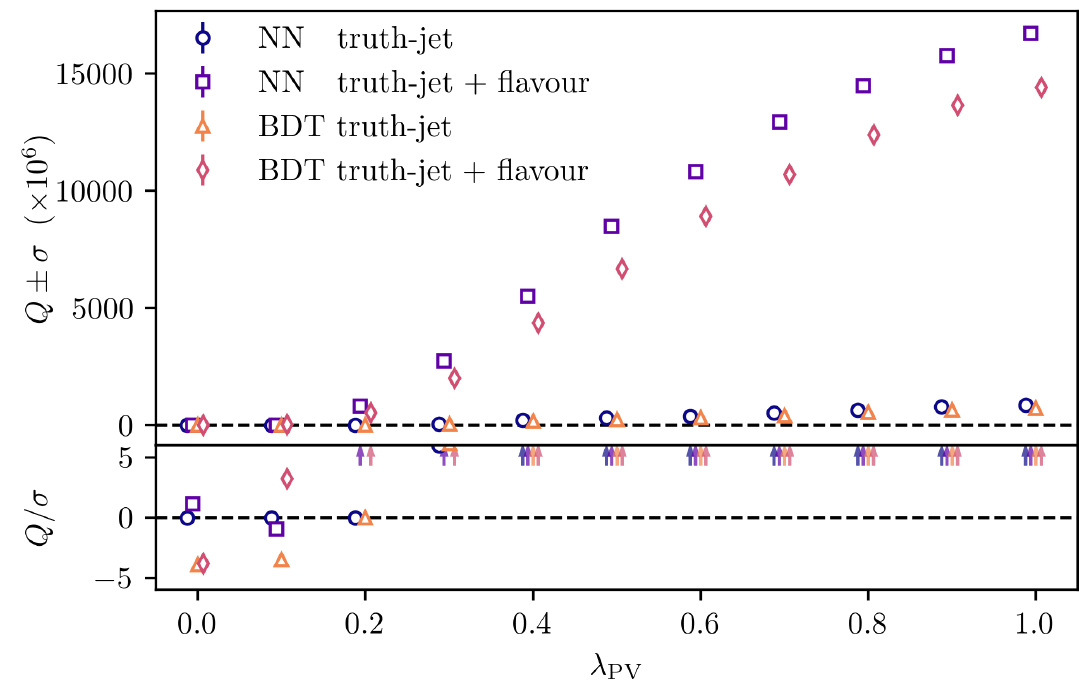
Figure 9 . Test set evaluation score Q as for small values of λ PV , displayed for BDT and NN models applied to truth-jet data with and without the inclusion of parton flavour information. Small values of λ are further investigated in figure 10. All points use approximately two million events in their PV testing sets. Markers at each λ point are slightly offset to aid PV